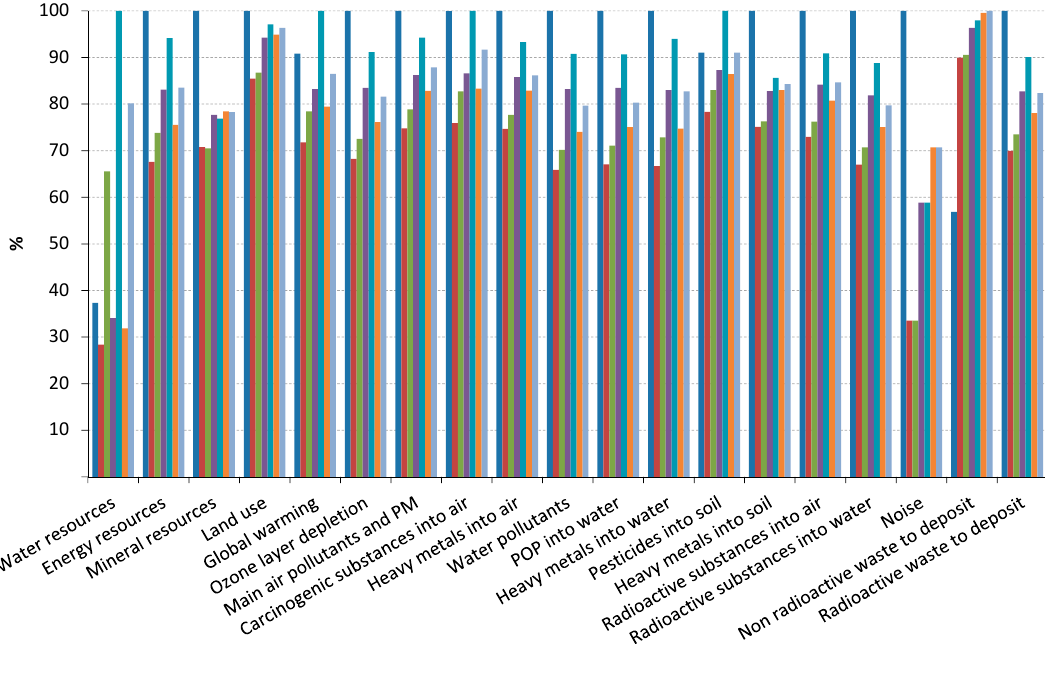
Figure 4. Impact assessment results: comparison between standard and alternative scenarios.